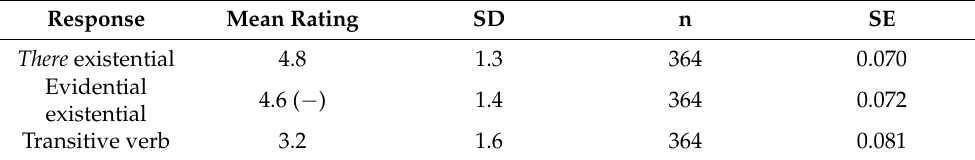
Table A3. Descriptive statistics for evidential existentiality norming study burn-in trial results. A + or − in the rating cell (respectively) represents a higher or lower mean score for that condition in the burn-in trials than in the main trials. Mean is calculated on raw (non-z-scored) ratings.